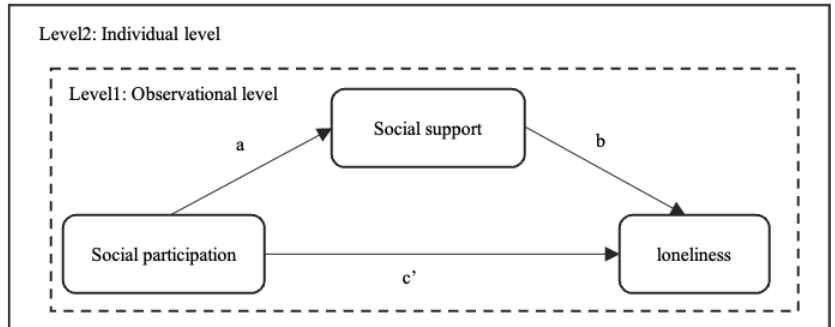
Figure 1. The core conceptual and analytical framework.